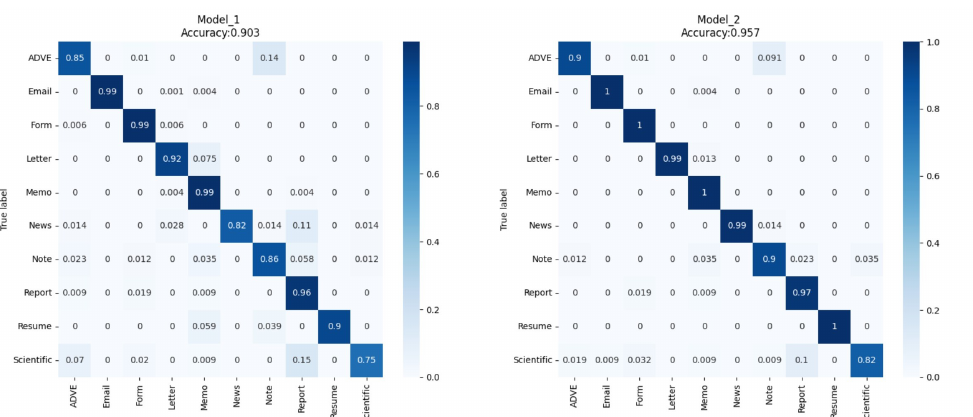
Figure 11. These are the confusion matrixes for the models from two different experiments carried out in this paper. The Model_1 matrix on the left is a model without RVL-CDIP pretraining, instead directly trained and tested on the Tobacco-3482 dataset. The Model_2 matrix on the right is a model trained on RVL-CDIP prior and then trained and tested on the Tobacco-3482 dataset. The visual stream in both methods uses pre-trained ImageNet weights in this model.